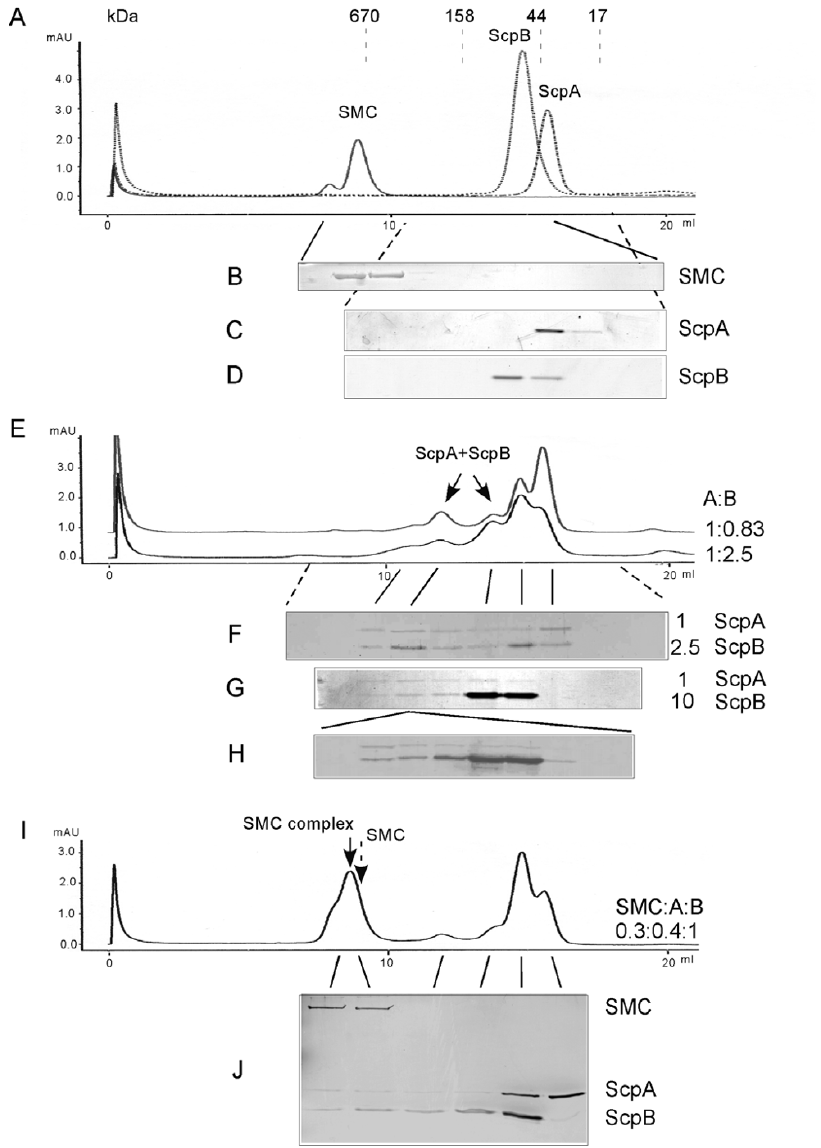
Figure 1 Analytical gel filtration assays with SMC and ScpA and ScpB. A) Reference runs for purified SMC (0.3 nmol), ScpA (0.4 nmol) and ScpB (1 nmol), all three profiles were merged. Dashed lines show the position of peaks for proteins of gel filtration stand- ards. The void volume peak is indicated by a white triangle. B-D) Coomassie stained SDS PAGE showing continuous fractions collected during gel filtration. Full or dashed lines show the regions from which the fractions were taken. E) ScpA mixed with ScpB in two different proportions, 1:2.5 nmol (lower graph) and 1:0.83 nmol (upper graph). Arrows indicate the existence of at least two discrete peaks containing different forms of the ScpA/B complex. F-G) Coomassie blue-stained SDS-PAGE showing continuous fractions collected during gel filtration. Dashed lines indicate the region from which the fractions were taken, full lines indicate the position of the fractions within the elution profile, indicating peak elution of ScpA, ScpB or of the distinct ScpA/B complexes. G) corresponds to (F) with a 1:10 ration of ScpA to ScpB. H) The elution peak at 12 ml is subjected to a second round of gel filtration analysis, and fractions containing ScpA and ScpB are shown (stained with silver), I) SMC (0.3 nmol) incubated with ScpA (0.4 nmol) and ScpB (1 nmol) before gel filtration. The dashed arrow shows the position of the SMC peak in the absence of Scps, and the solid arrow peak elution of the SMC complex. J) Silver-stained SDS-PAGE with (non- continuous) fractions loaded corresponding to elution peaks from gel filtration (indicated by solid lines) shown in I). Note that the first two lanes in (J) correspond to the first two lanes in (B) and in (F), i.e. that SMC shifts to a higher molecular weight in complex with ScpA/B, and the ScpA/B are not present in these fractions in the absence of SMC